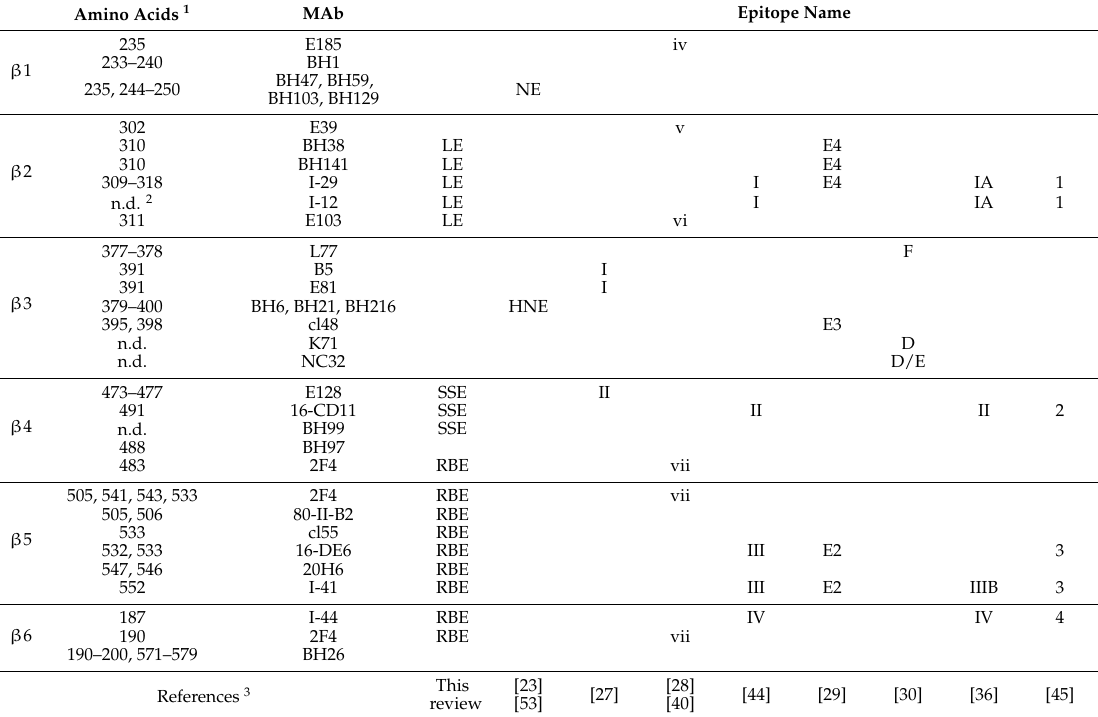
Table 1 should be replaced with: Table 1. Relationships between epitopes and